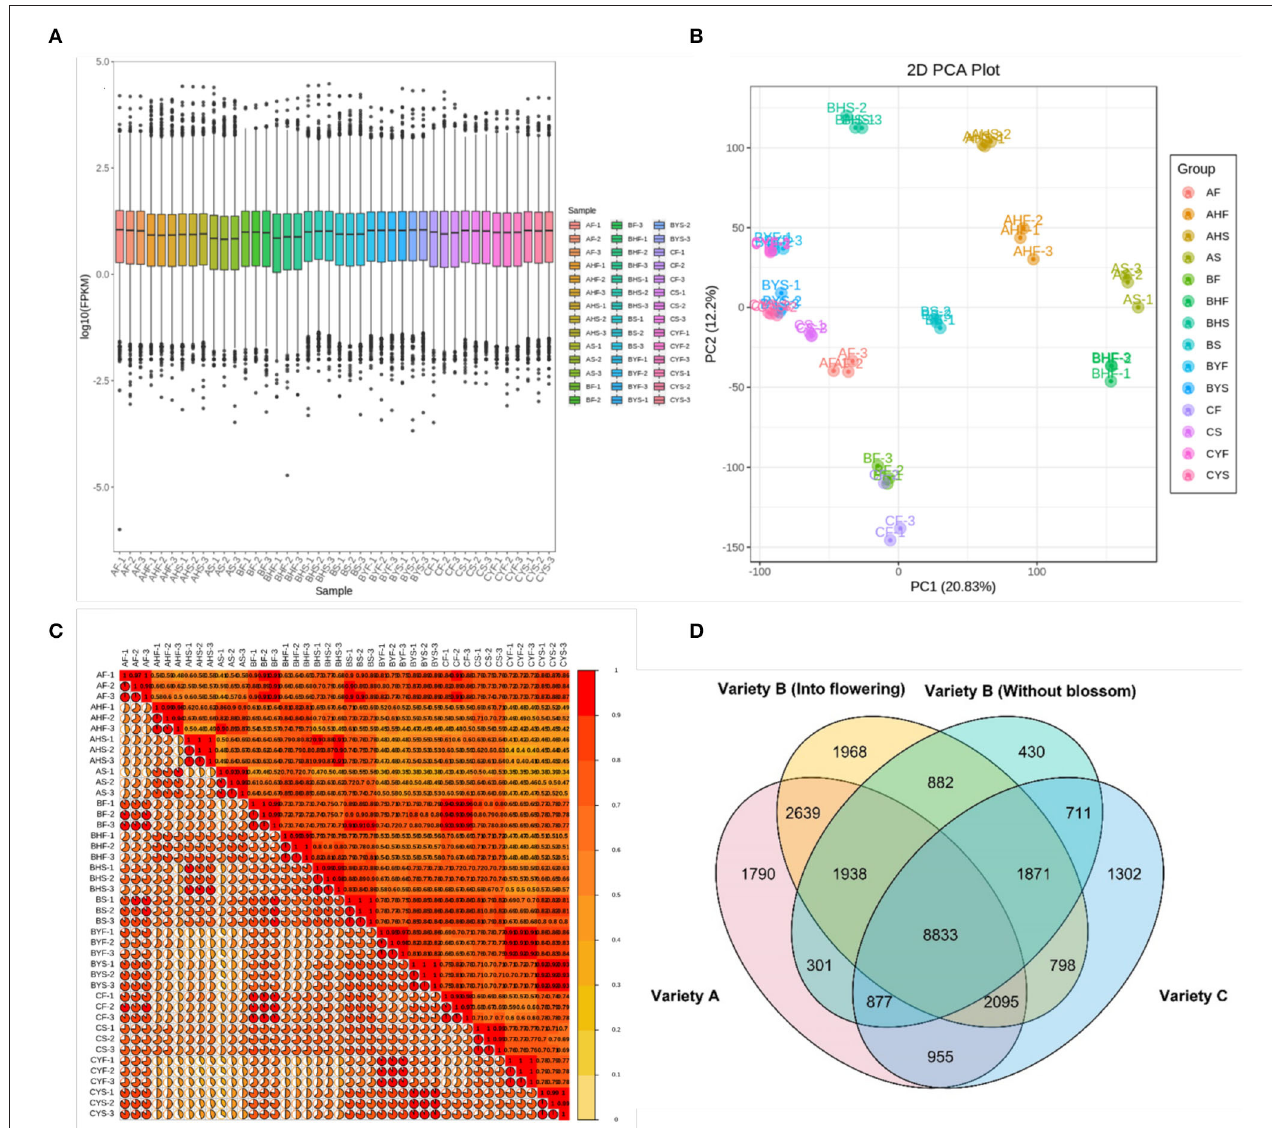
FIGURE 2 | Summary of the transcriptome. (A) Gene expression levels as box plots of FPKMs. Ordinate represents Log10 FPKMs and Abscissa symbolizes sample names. The box plot for each region represents five statistics (from top to bottom: maximum, upper quartile, median, lower quartile, and minimum), the outlier is shown in black dots. (B) The PCA plot of all RNA-sequence samples. (C) The correlation heat map of the samples. (D) A Venn diagram representing common and specific DEGs in three mango